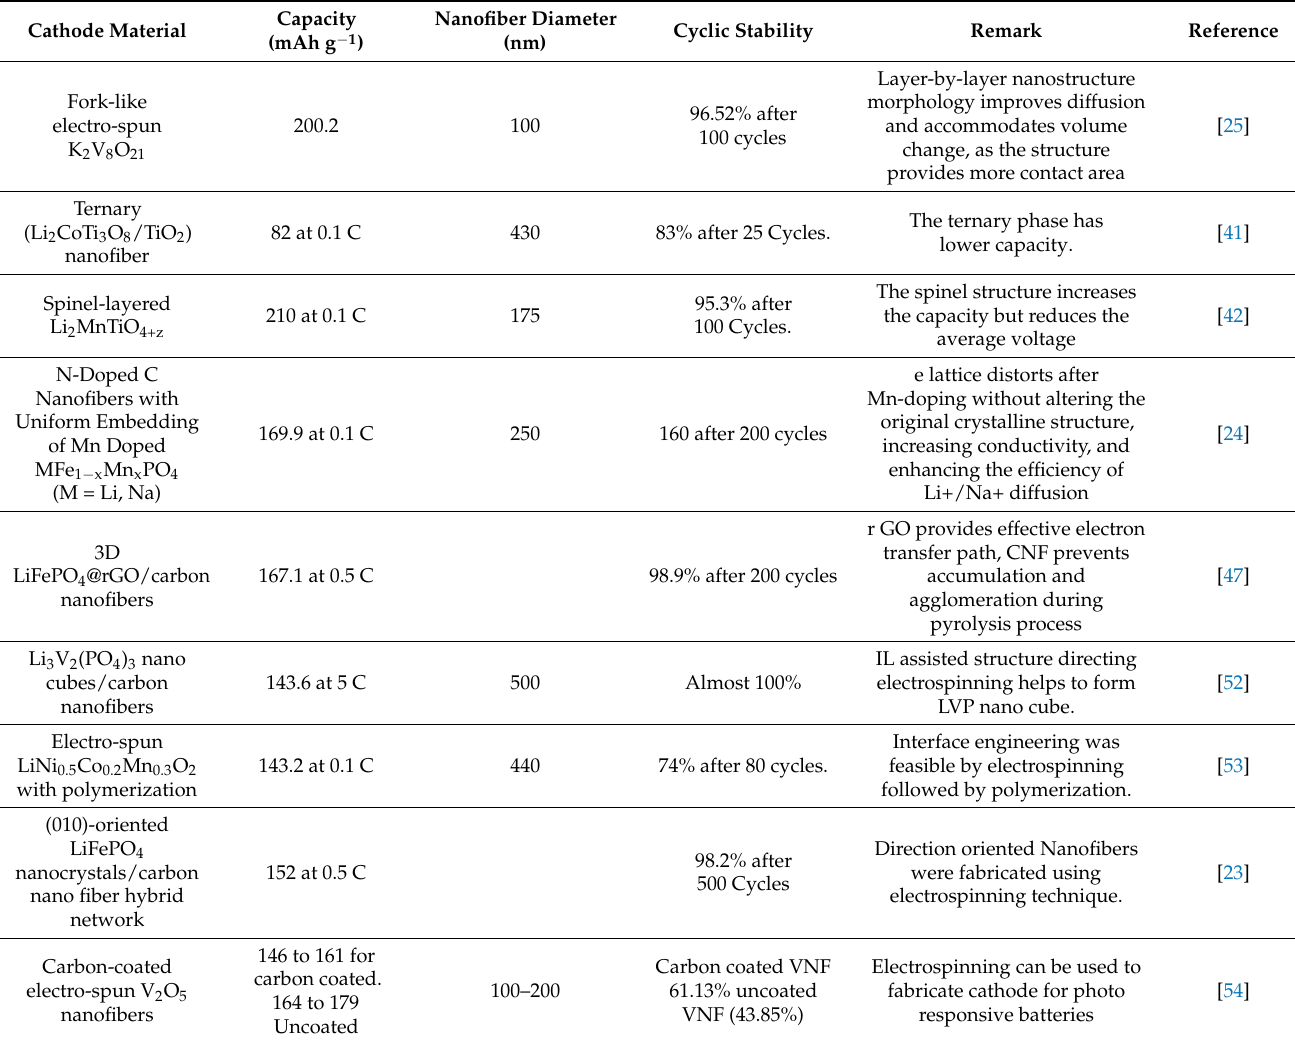
Table 1 provides an overview of the recent advanced electrospun cathode material. Table 1. Recent Electro spun Cathode Materials used in